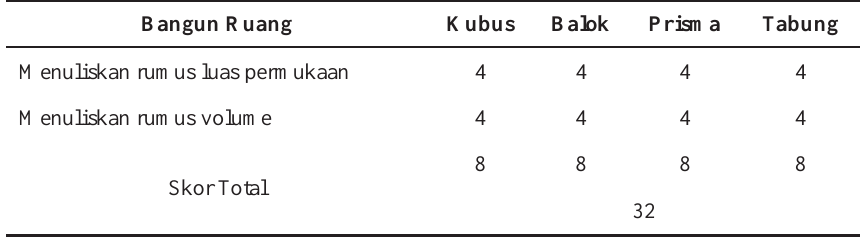
Tabel 1. Indikator Penilaian Hasil Mind